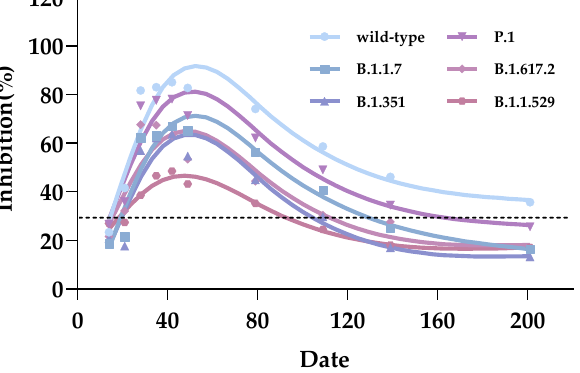
Figure 3. Longitudinal kinetics and duration effectiveness of vaccinated serum inhibiting antibodies. The ordinate of the coordinate axis is the inhibition rates, and the abscissa represents the different sampling dates following receipt of the first CoronaVac dose. The range of 28–35 days received the second dose of CoronaVac. The dotted lines represent the cutoff at 30% inhibition.